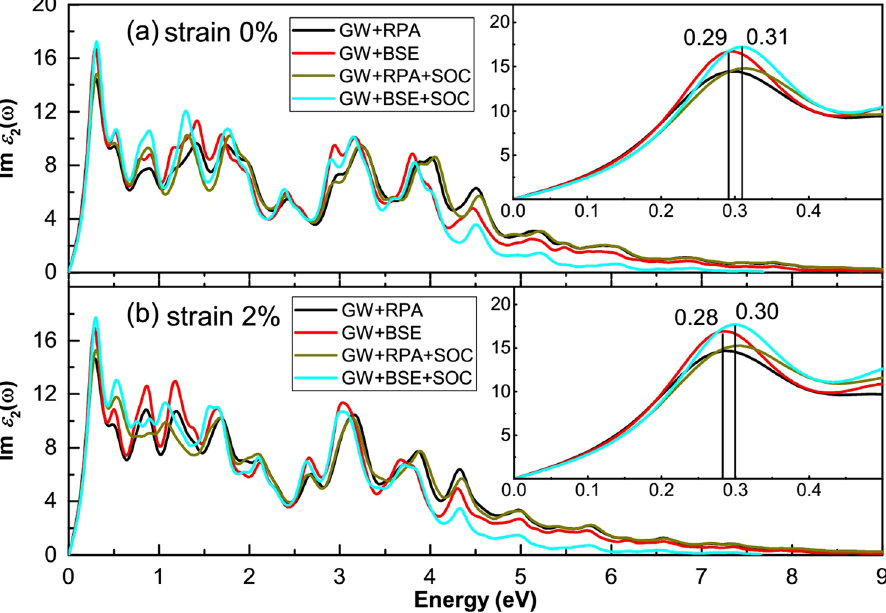
Figure 5. Imaginary part of dielectric functions for ( a ) 0% and ( b ) 2% EQ strained stanene with and without e–h interaction and SOC, i.e., GW + BSE, GW + RPA, GW + BSE + SOC and GW + RPA + SOC,